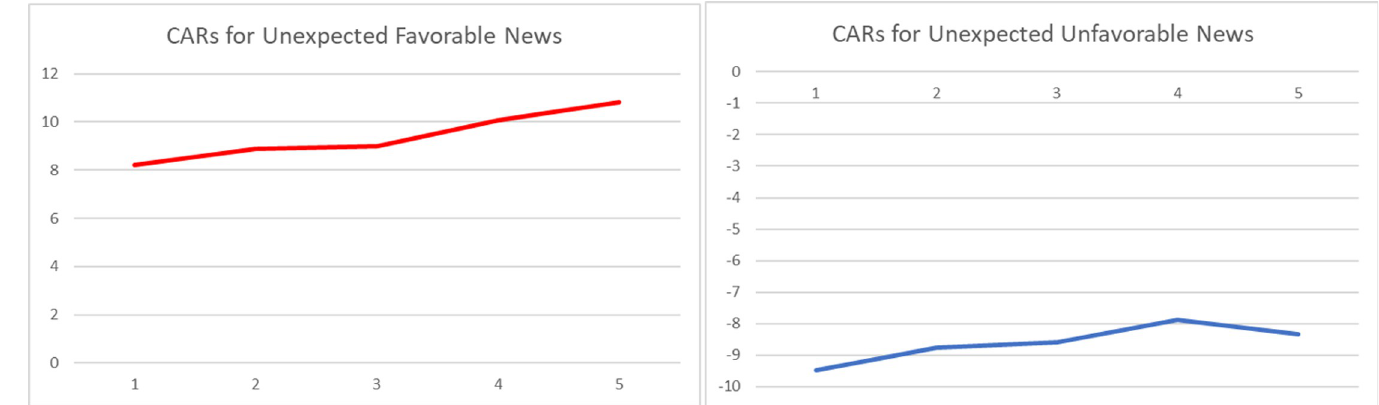
Fig 4. Graphs of daily CARs during a 5-day window following arrival of unexpected event (COVID19 period– 11.03.2020 to 12.08.2021).